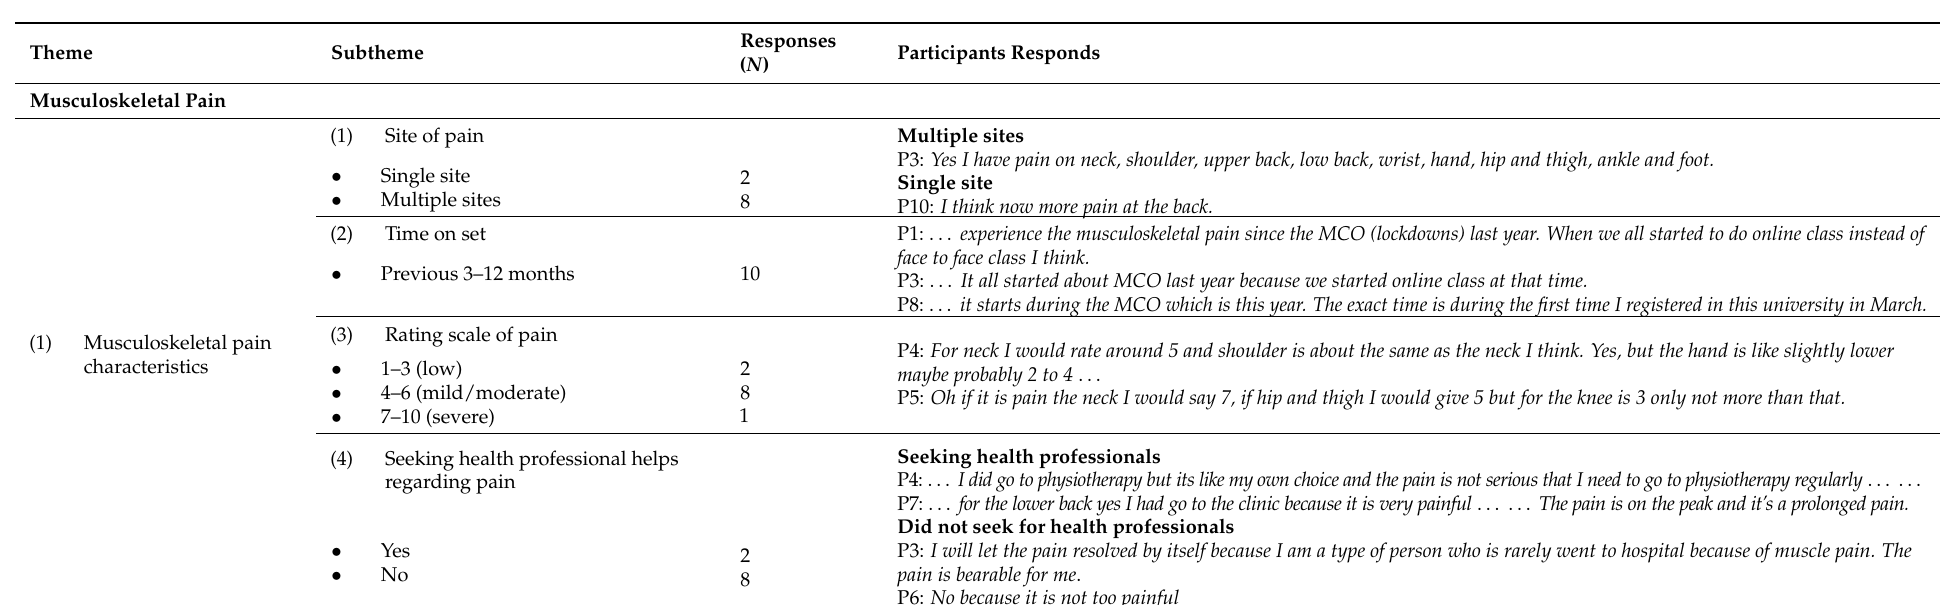
Table 4. Themes and